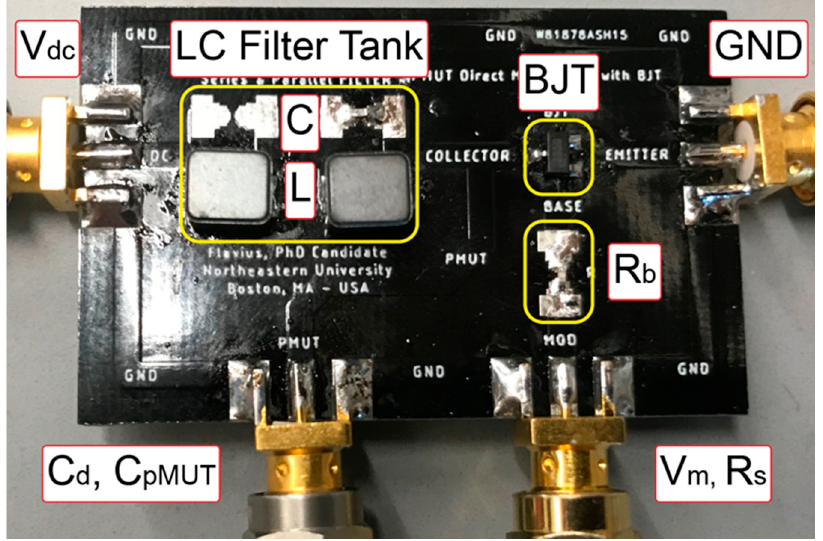
Figure 11. Printed Circuit Board (PCB) implementation of the dMUT system based on the parameters in Table 1 with the exception of the DC biasing voltage that was increased to V dc = 7 V for high performance application (29).